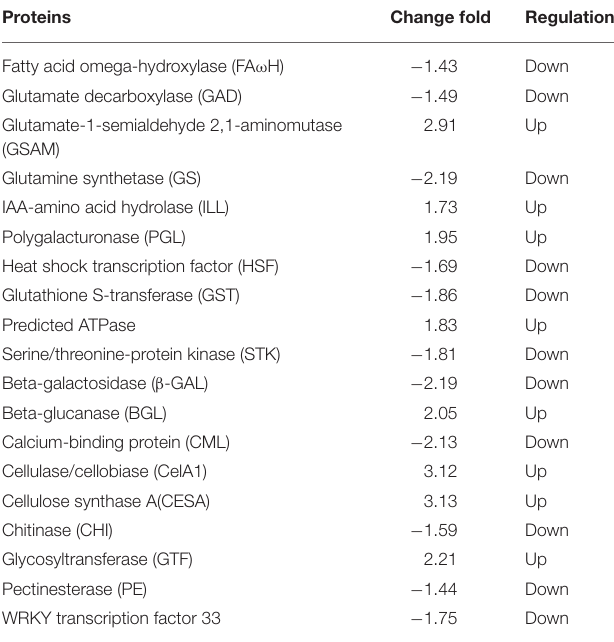
TABLE 3 | Regulation and change fold of differentially expressed proteins involved in CI process of CK 8- vs. 0-day group. Proteins Change fold